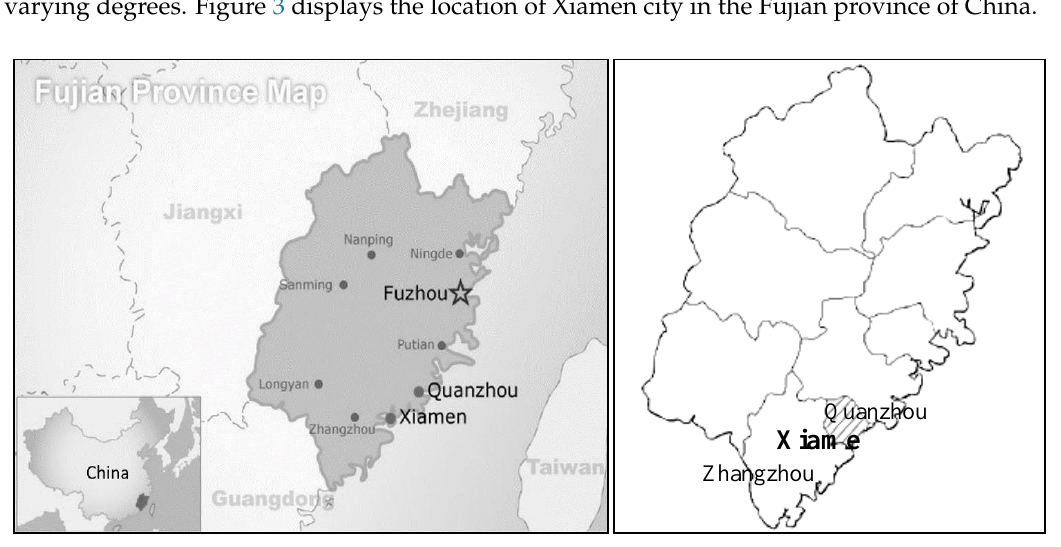
Figure 3. The location of Xiamen in Fujian province.